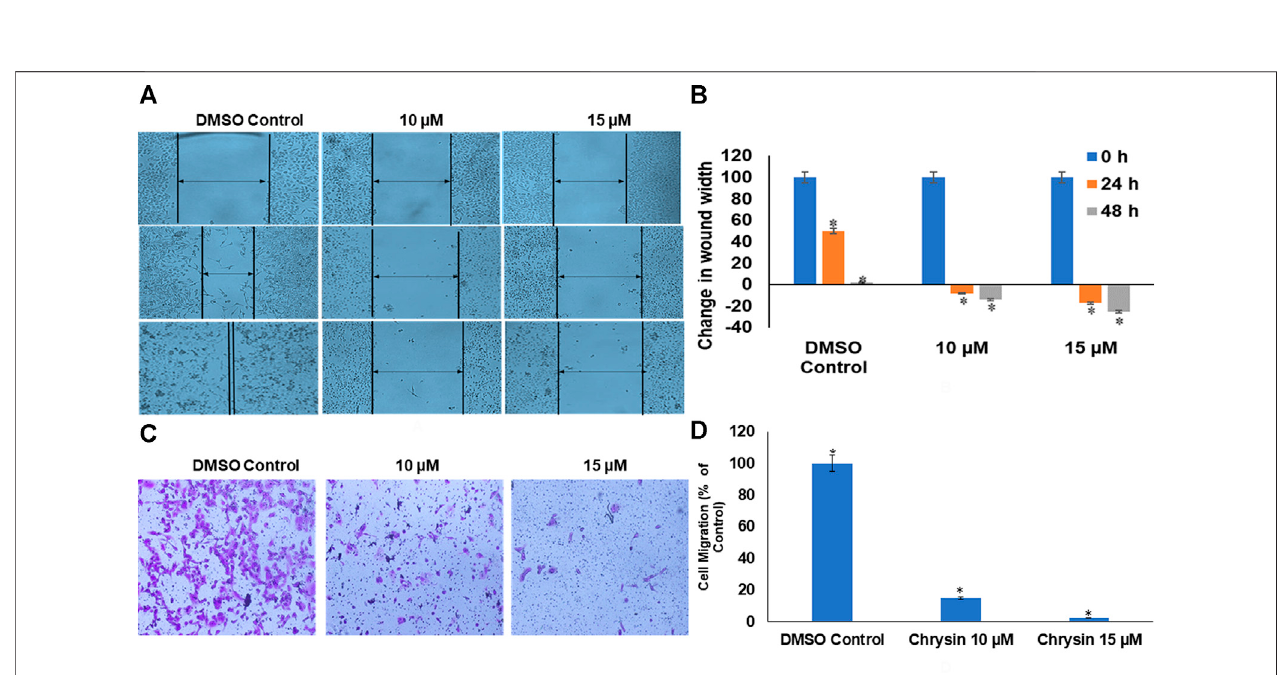
Chrysin Inhibits DNMT Activity in HeLa Cells Chrysin inhibited DNMT activity in HeLa cells in a dose-